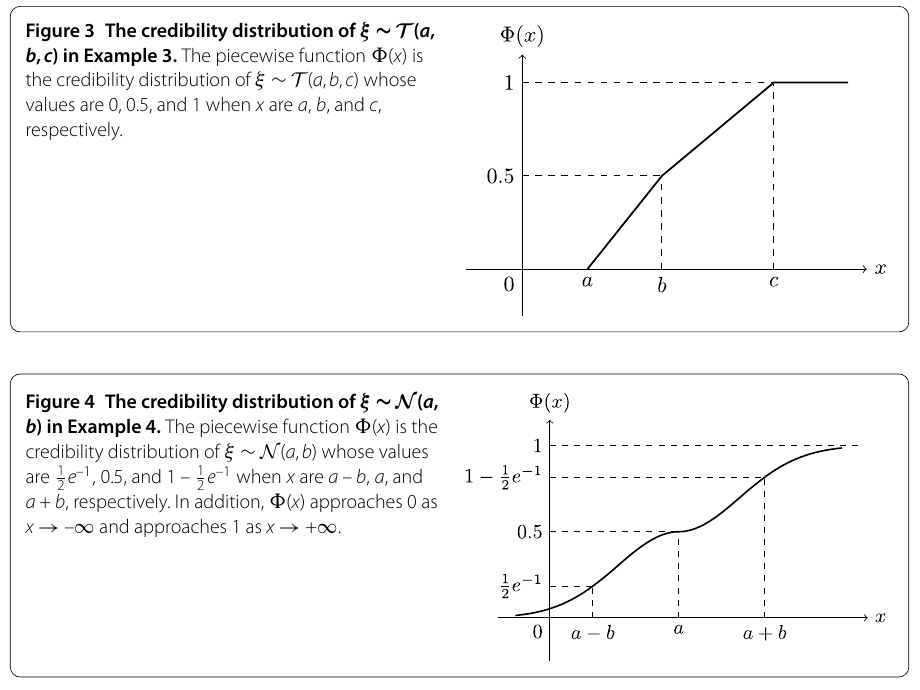
Figure 3 The credibility distribution of ξ ∼ T ( a , b , c ) in Example 3. The piecewise function (cid:5) ( x ) is the credibility distribution of ξ ∼ T ( a , b , c ) whose values are 0, 0.5, and 1 when x are a , b , and c , respectively.